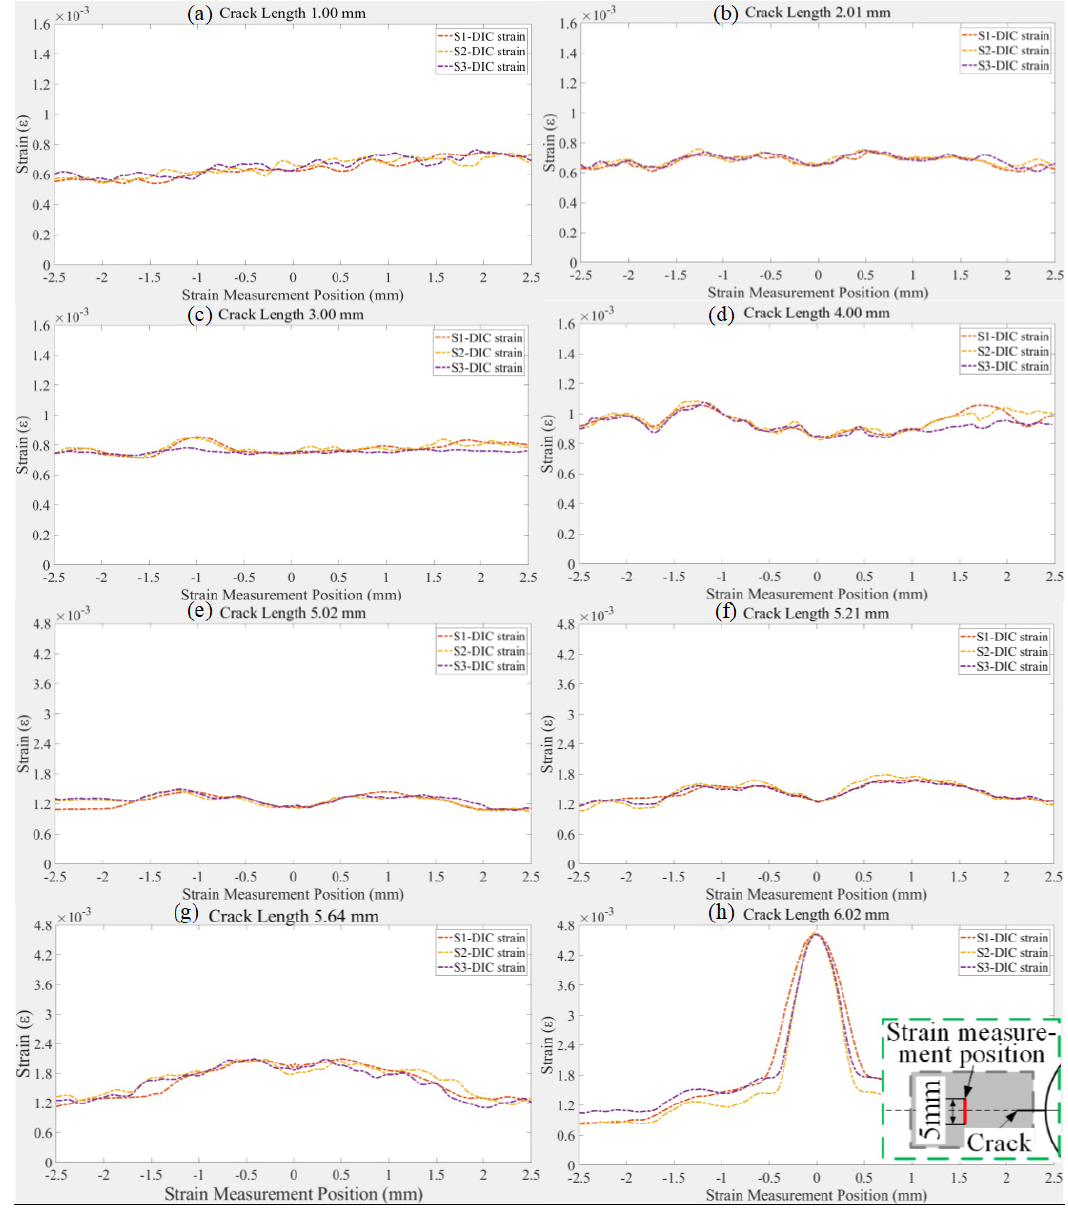
Figure 7. The measurement results of the continuous strain curves at and in front of the crack tip were measured by the DIC method, and the ( a )–( h ) show the continue strain variation with crack propagation.